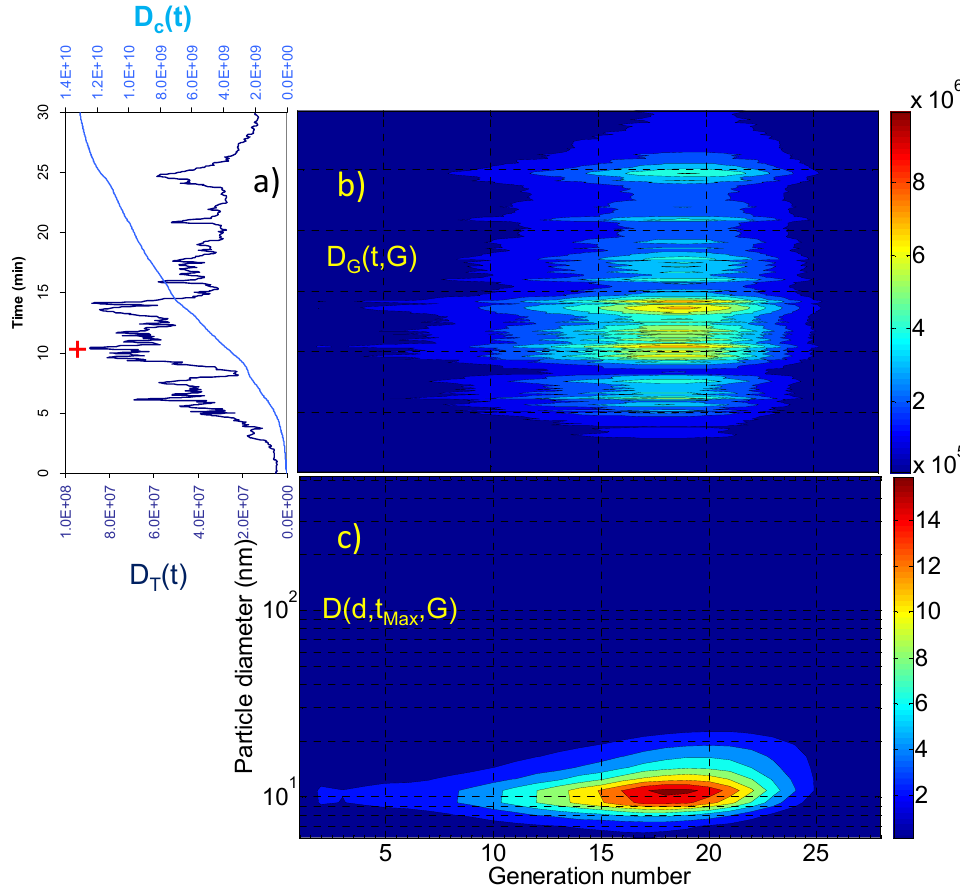
Figure 7. Kitchen, lunch preparation and eating: ( a ) total instant dose D T (t) and cumulative dose D c (t) as a function of time; ( b ) instant dose per airway generation D G (t,G) as a function of time and airway generation number; ( c ) maximum instant dose D(d,t Max ,G) at the maximum D T (t) value (the red cross in (a)) as a function of particle diameter and of airway generation